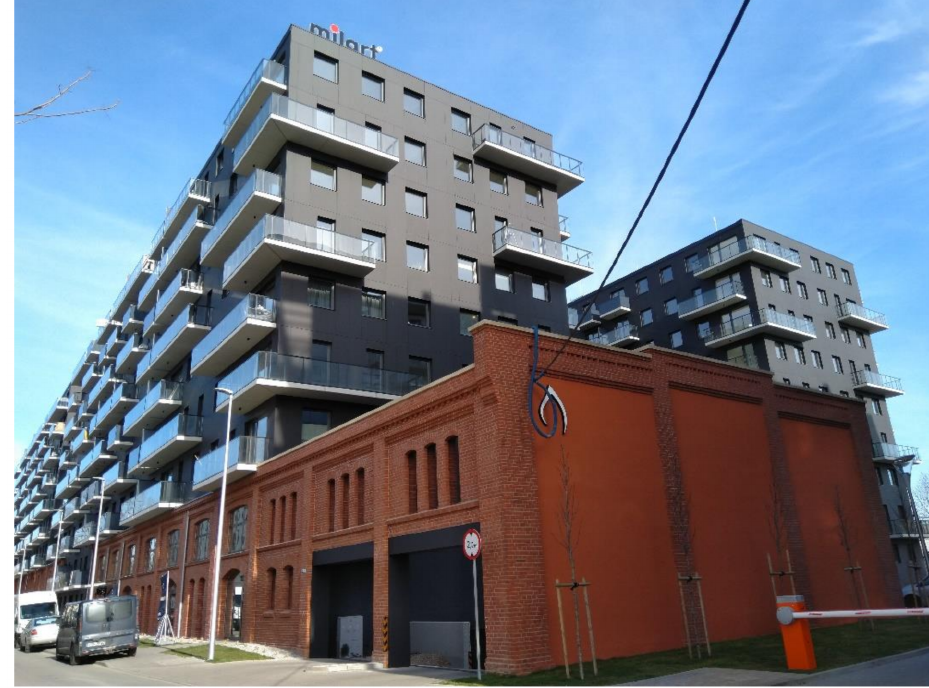
Figure 12. Significantly extended stable in the barracks complex in Wrocław (photo by M. Rudnicka-Bogusz).